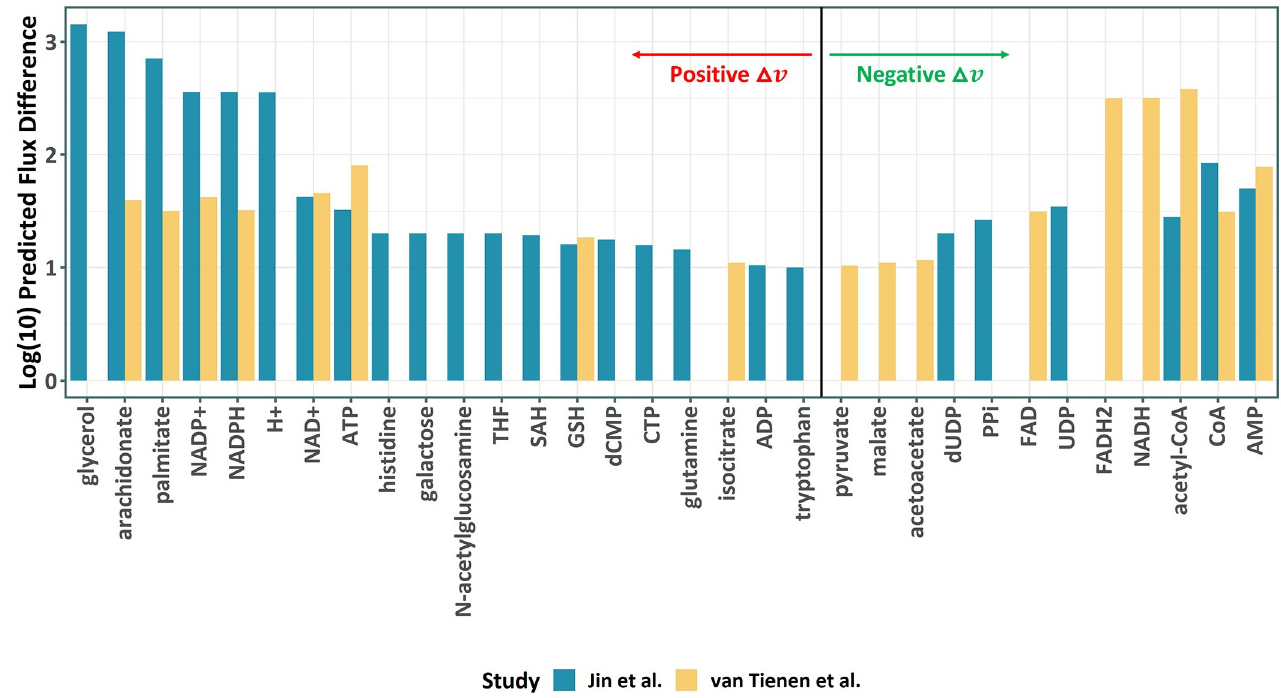
Fig 4. Alterations in metabolite flux throughput in T2D patients as predicted by Δ FBA.